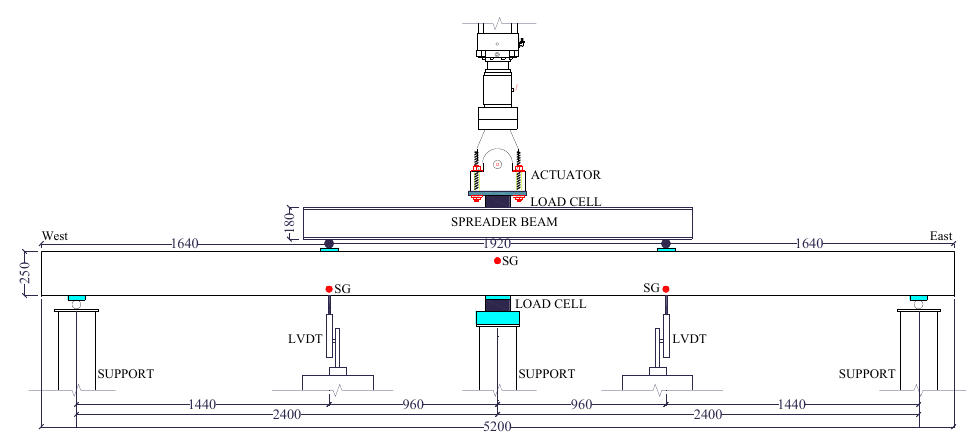
Figure 6. Test set-up and instrumentation (dimensions are in mm).